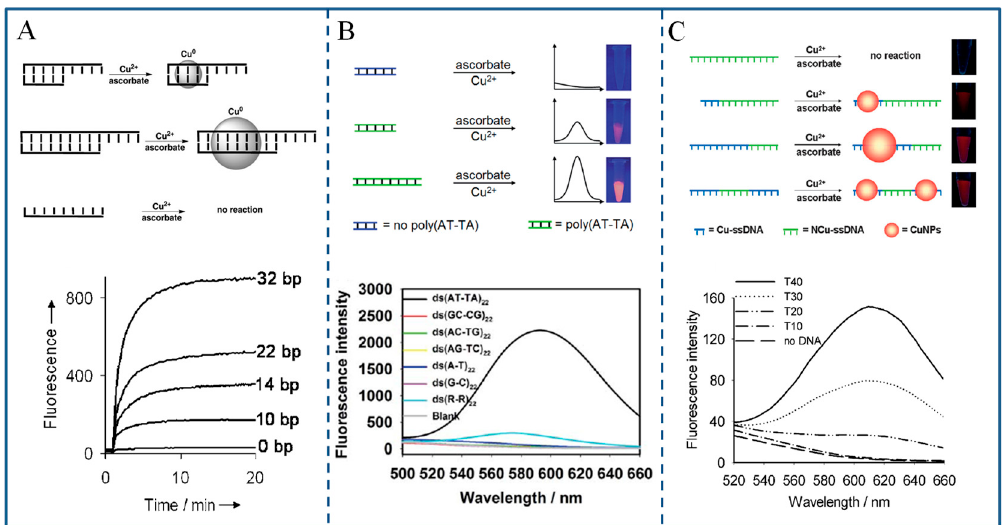
Figure 3. Schematic illustration of fluorescent CuNCs templated by various DNA: ( A ) dsDNA. Reprinted with permission from Ref. [63]. Copyright 2010, Wiley-VCH. ( B ) poly(AT-TA) dsDNA. The green dsDNA is the poly (AT-TA) sequence, while the blue dsDNA represents other sequences. Reprinted with permission from Ref. [65]. Copyright 2014, Royal Society of Chemistry. ( C ) polyT-DNA. The blue ssDNA is the polyT sequence, while the green ssDNA represents other sequences. Reprinted with permission from Ref. [67]. Copyright 2013, Wiley-VCH. In each case, the fluorescence intensity is proportional to the length of the template.